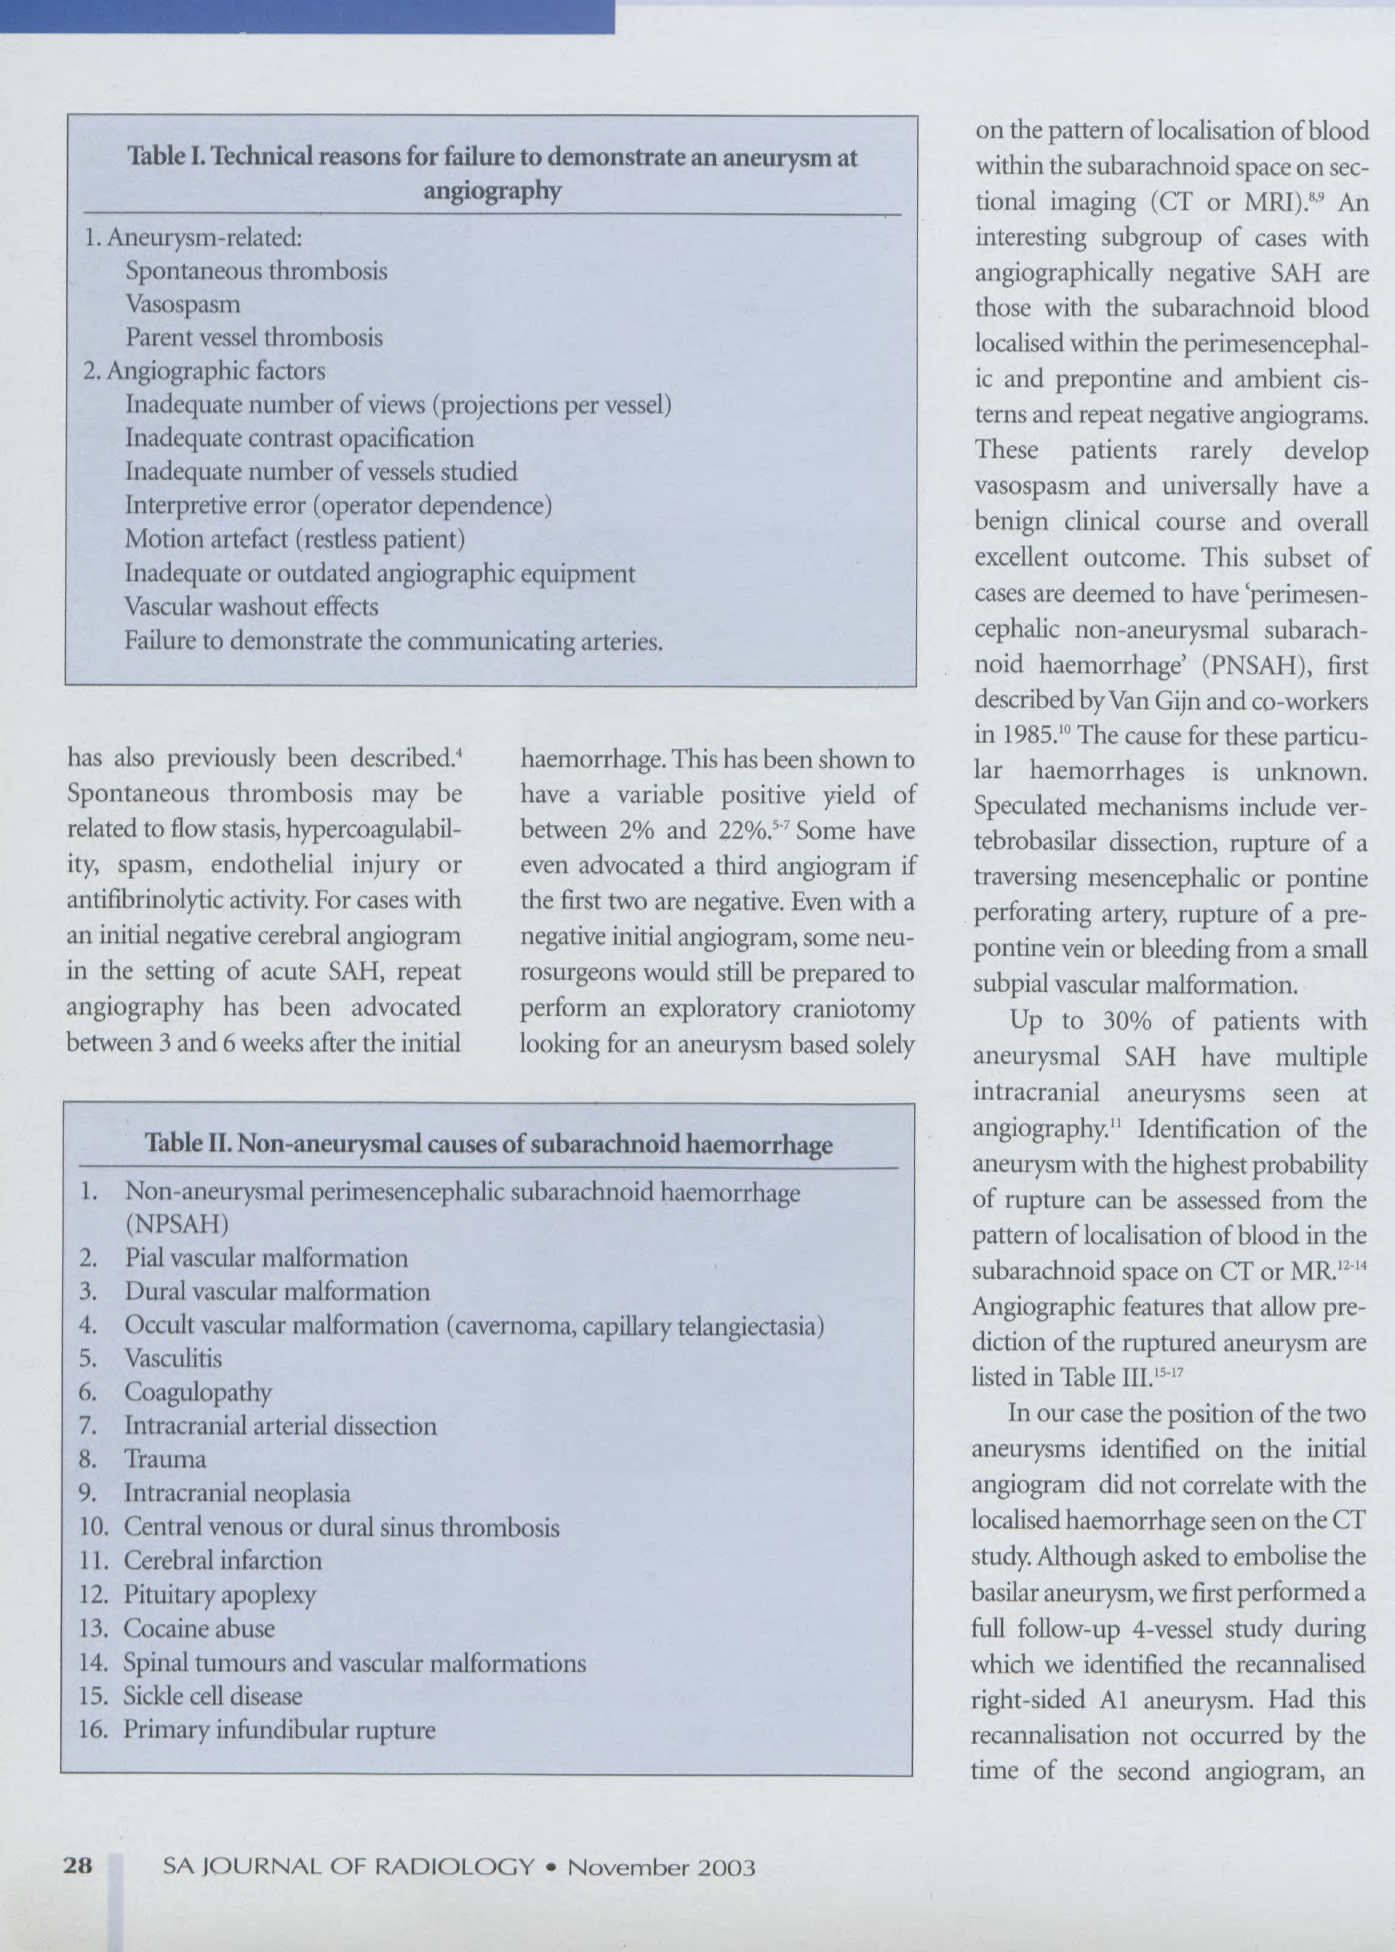
Table I. Technical reasons for failure to demonstrate an aneurysm at angiography